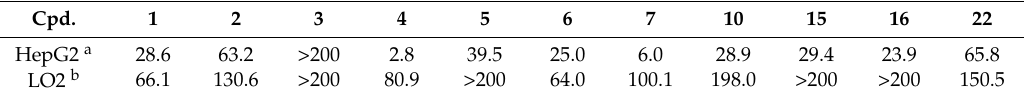
Table 1. Some of urushiol derivatives’ inhibitory activity against HepG2 and LO2 in vitro (half maximal inhibitory concentration (IC50), µ M, 72 h).